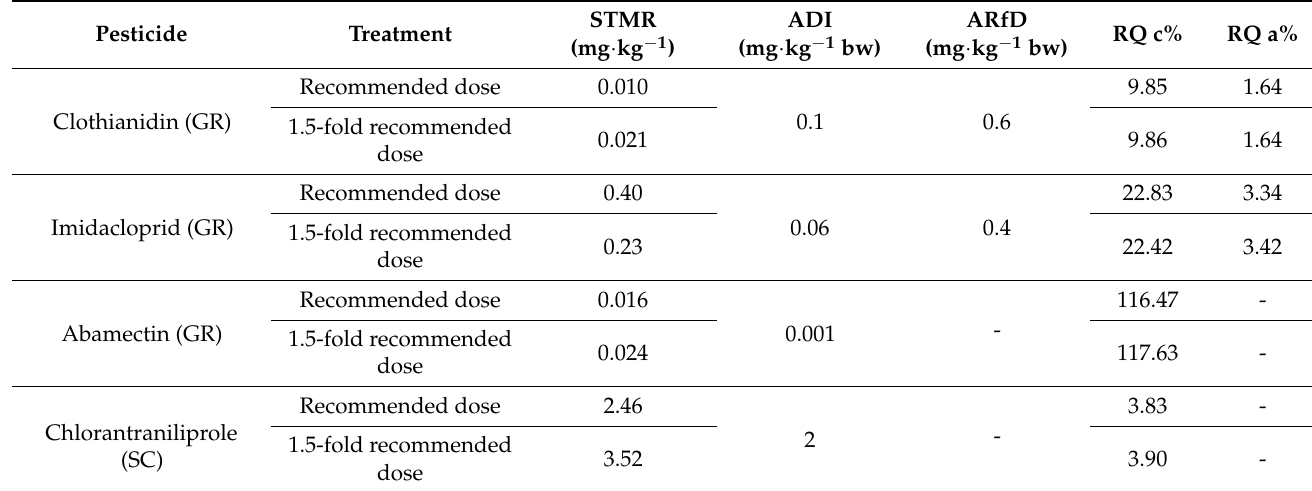
Table 8. Risk quotient and risk probability of 4 pesticides in celery after application at the recommended dose and 1.5-fold the recommended dose.